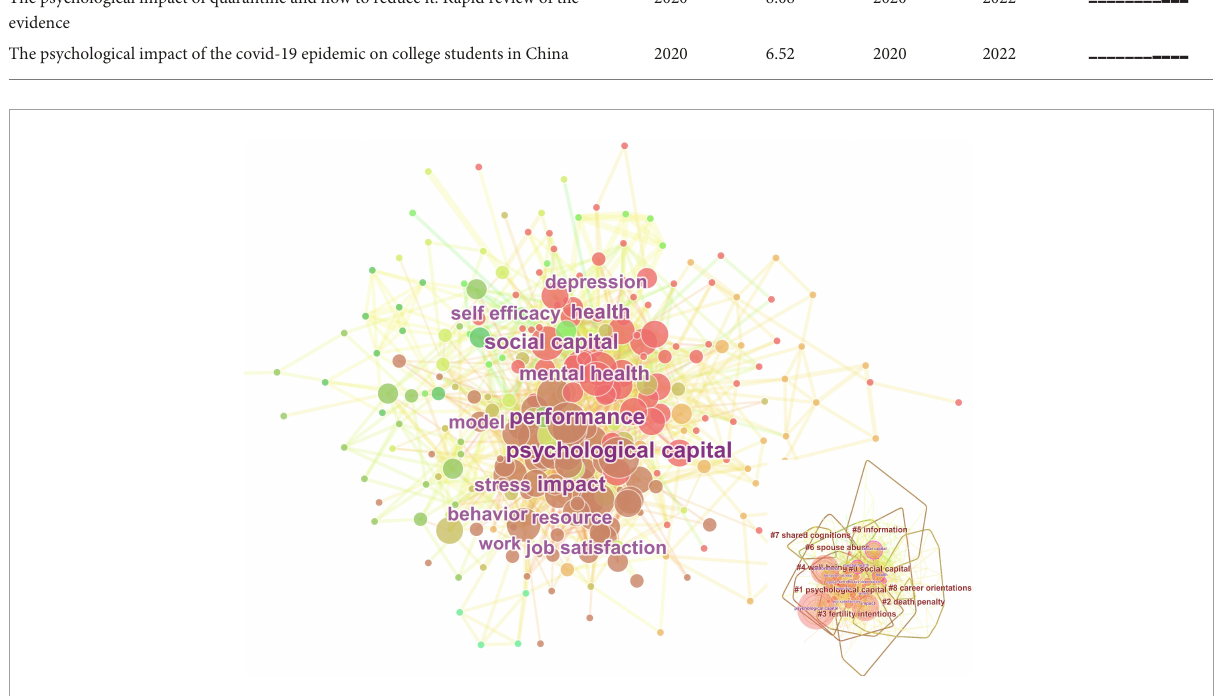
FIGURE6 co-occurrence network of